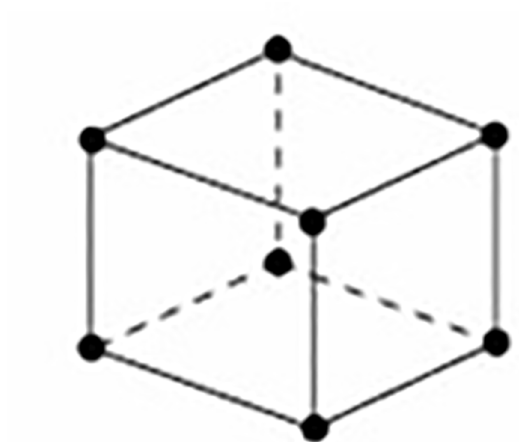
Figure 4. Finite Element DC3D8